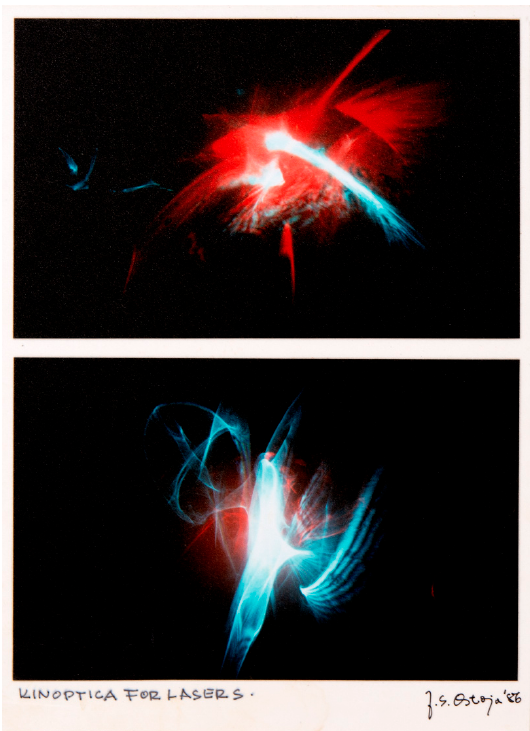
Figure 7. Józef Stanis ł aw Ostoja-Kotkowski. Kinoptica for lasers 1986. Colour photographs. Gift of the Estate of Edward Stirling Booth. Flinders University Art Museum Collection 4241.223. Photograph by Flinders University. © the Estate of the artist. Published with permission.